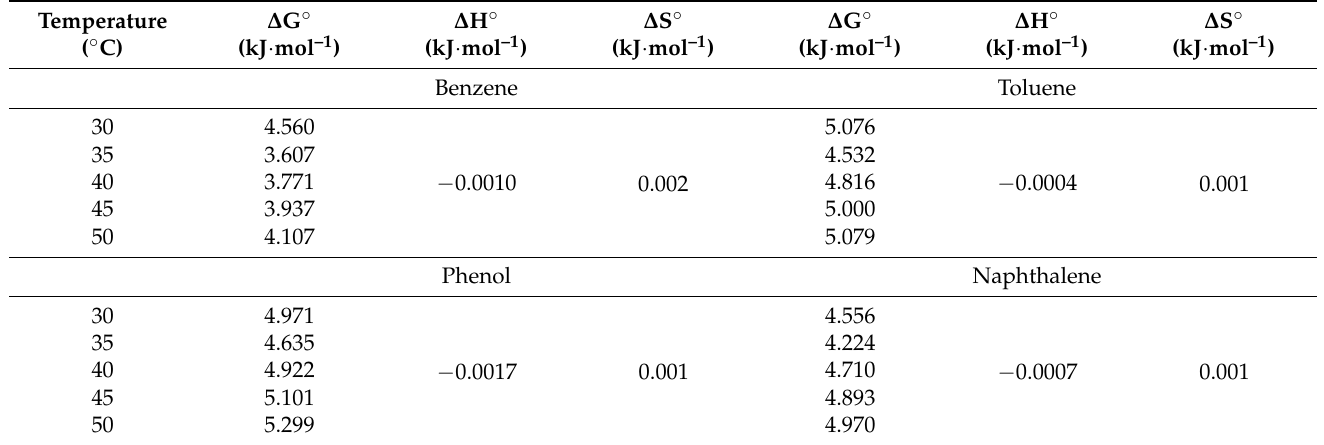
Table 5. Thermodynamic parameters for adsorption of model HCs on